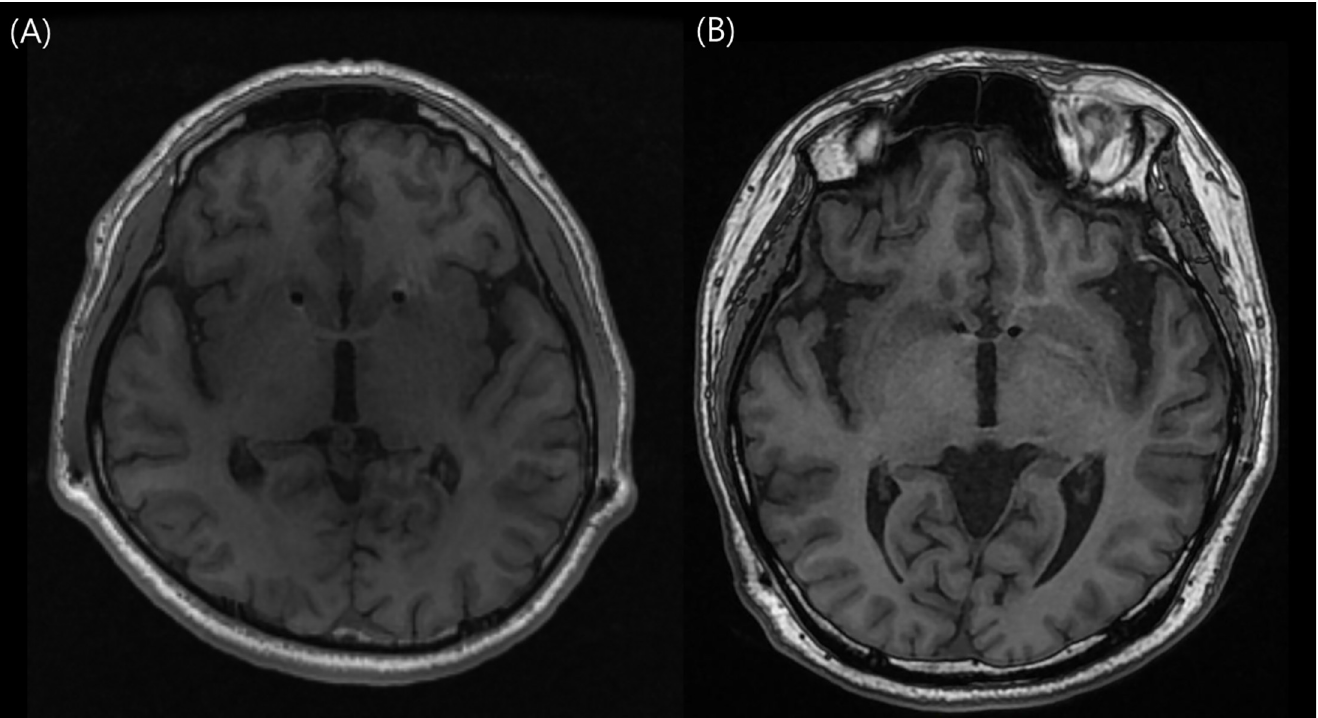
Fig 1. Postoperative magnetic resonance imaging after electrode insertion. (A) Anterior limb of internal capsule (B) Nucleus accumbens.